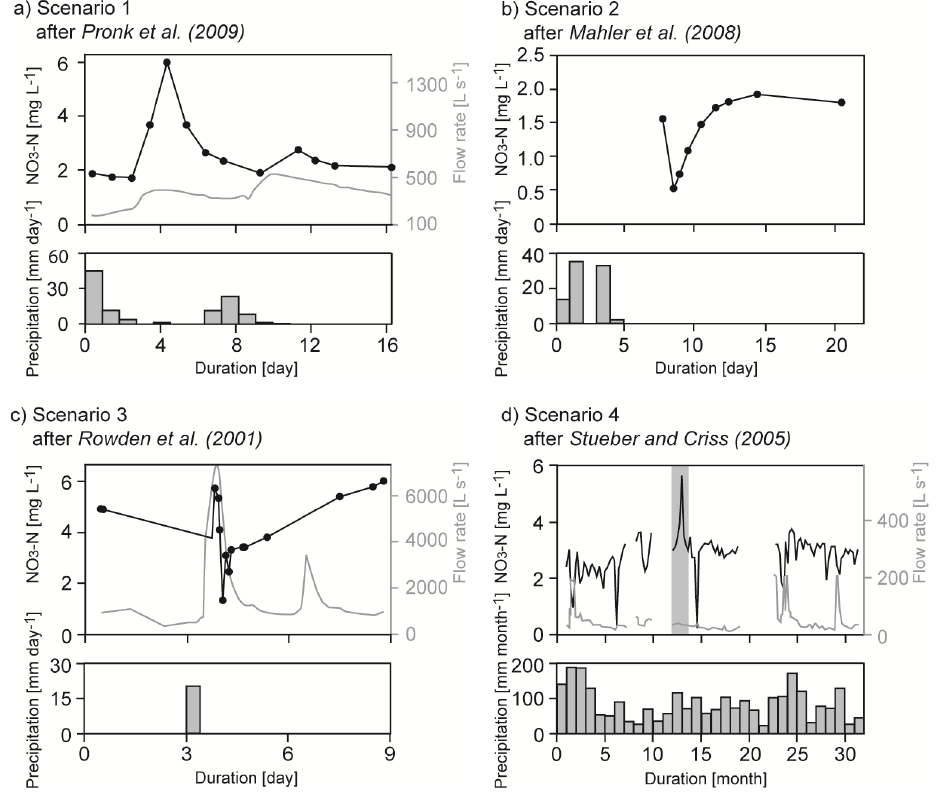
Figure 6. Illustrating 4 case studies: Predominance of (a) mobilised nitrate; (b) diluted nitrate; (c) mobilisation and dilution during one single event; (d) mobilisation and dilution during multiple rainfall events. The grey bar in the upper diagram shows the only event in the data set where mobilisation occurred instead of dilution during storm